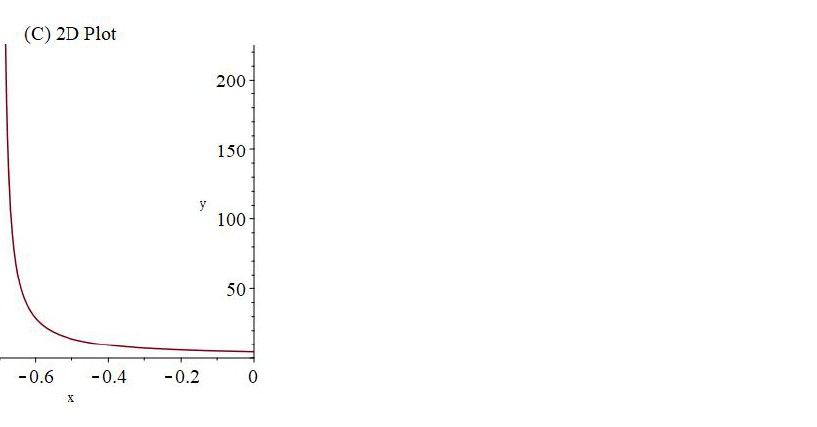
Figure 1. Two-dimensional and three-dimensional plots of the bright soliton solution | Equation ( 11 ) | for ε 1 = − 0.9, ε 2 = 0.5, ε 3 = − 0.2, ε 4 = 0.1, η 1 = 0.5, η 2 = 0.5, Γ = 2, y = 0.